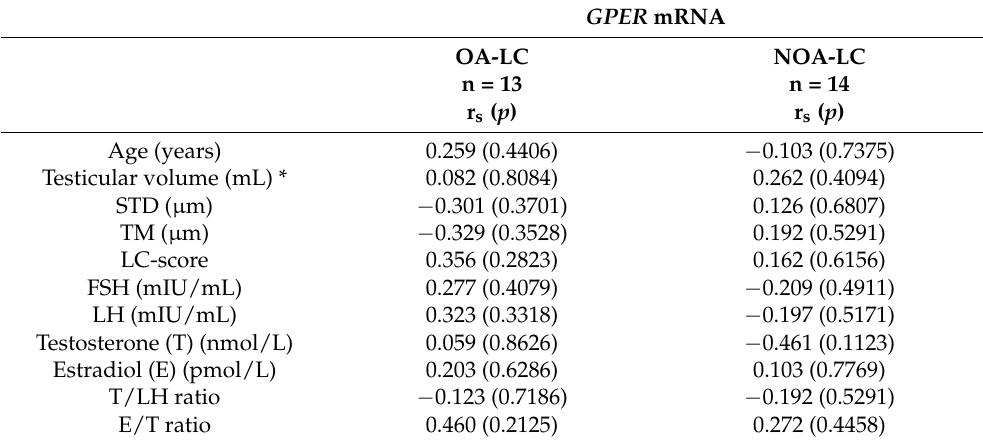
Table 7. Spearman’s rank correlation (r s ) between the GPER -LC mRNA expression level and age, parameters of histological evaluation and hormonal levels in OA-LC and NOA-LC groups. GPER